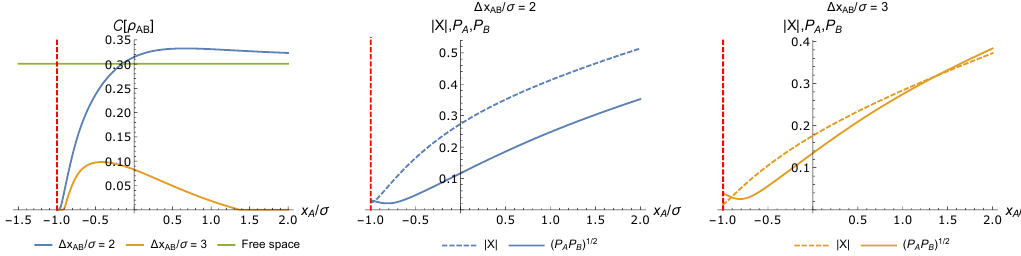
Figure 4 . Left: a plot of concurrence for the CW mirror (in red at time t = (cid:0) 1), as a function of the position of detector A for various (cid:12)xed detector separations (cid:1) x , with (cid:20) = 0 : 5 ; (cid:10) = 1 ; (cid:27) = 1. p Middle: the nonlocal term j X j and local noise P A P B terms for the (cid:1) x = 2 (cid:27) trajectory in the p left (cid:12)gure. Right: the nonlocal term j X j and local noise P A P B terms for the (cid:1) x = 3 (cid:27) trajectory in the left (cid:12)gure. The small region where the two curves intersect give the small entanglement enhancement region. Note the small zones of entanglement death near the mirror on the left plot p for both cases; these appear in the other two plots where we see that j X j < P A P B very close to the